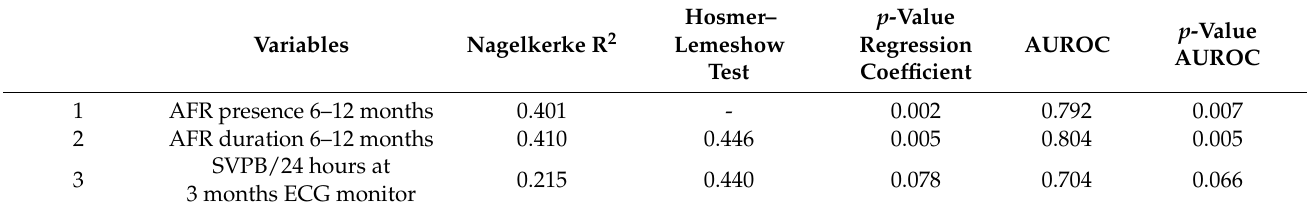
Table A5. Selection of independent predictors by bivariate linear regression/univariate analysis for very late AFR (over 12 months).